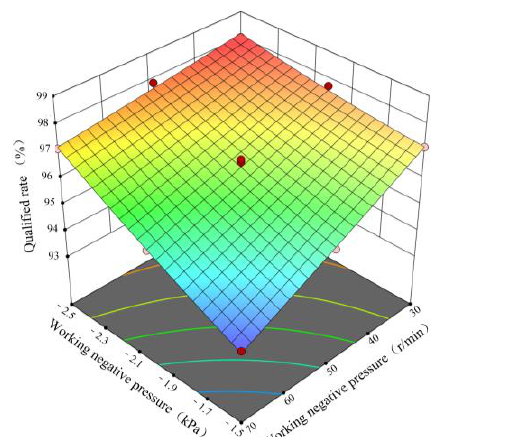
Figure 19. Response surface diagram of the empty broadcast rate. Figure 20. Response surface diagram of the hole number qualified rate.